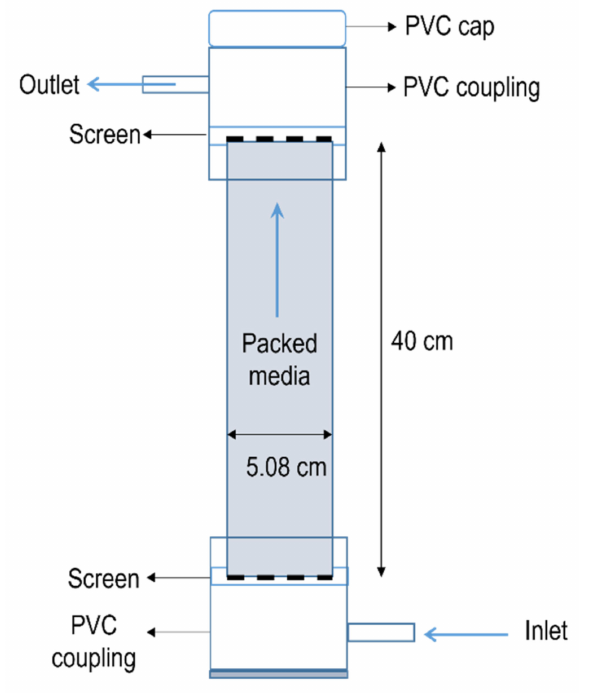
Figure 1. The design of the upflow denitrification bioreactor employed in this study.